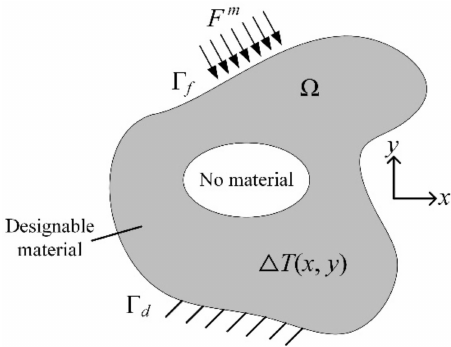
Figure 1. Generalized design domain of thermo-elastic